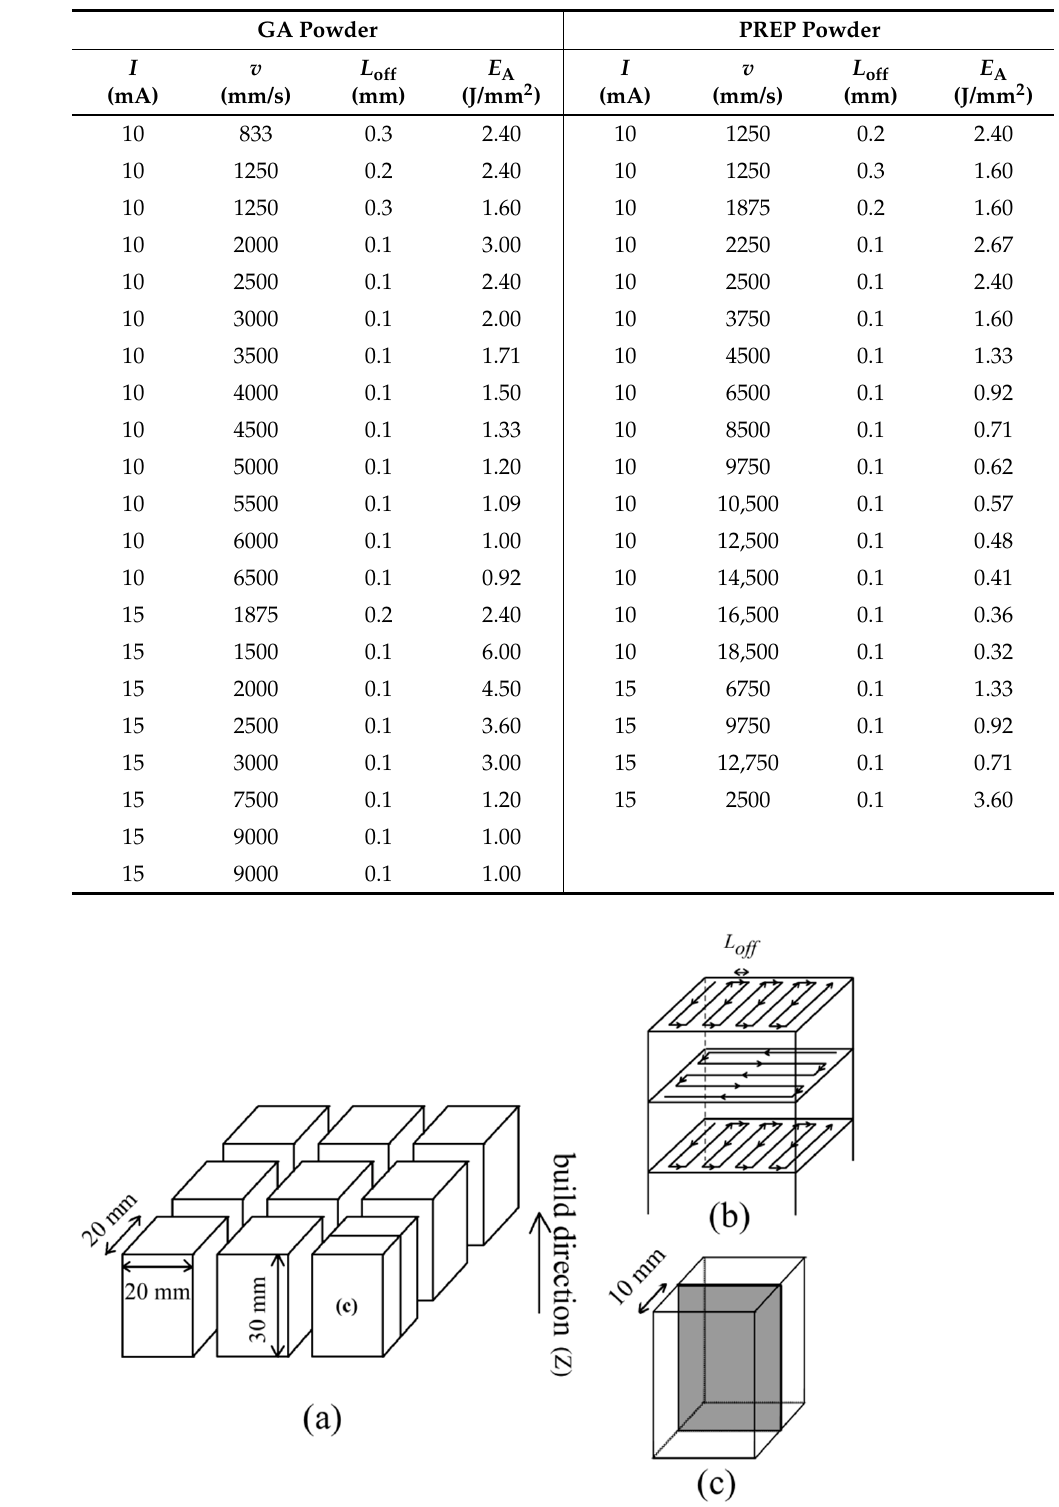
Figure 3. Schematic diagrams of ( a ) one batch of as-EBM samples; ( b ) electron beam scans in a cross snake-like way with a specific L off and hatching layer of 50 μ m; ( c ) shows the microstructural char- acterization region. Table 4. Summary of the processing parameters of two types of GH4099 powders.